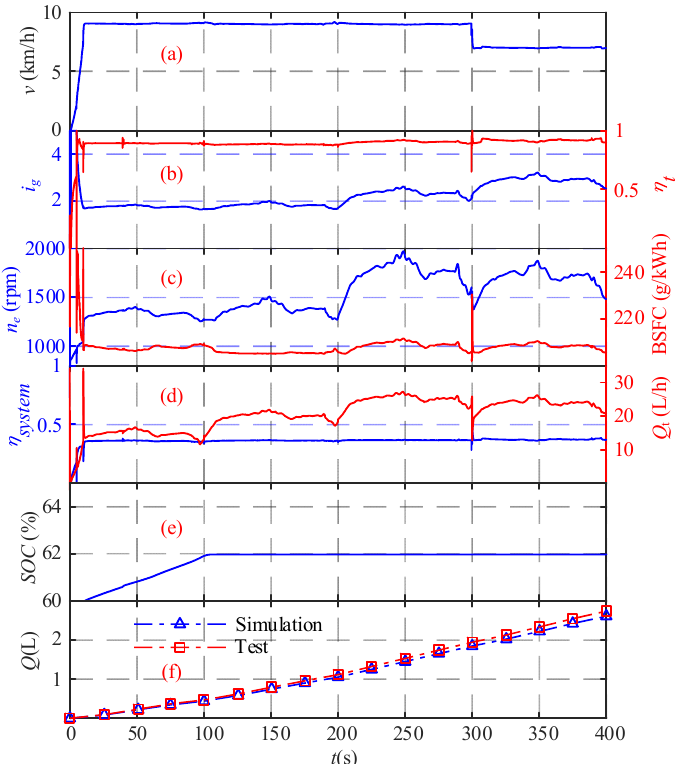
Figure 17. Results of the ploughing operation: ( a ) tractor speed, ( b ) transmission ratio and efficiency, ( c ) engine speed and BSFC, ( d ) system efficiency and instant fuel consumption, ( e ) SOC curve, ( f ) simulation and test fuel consumption.